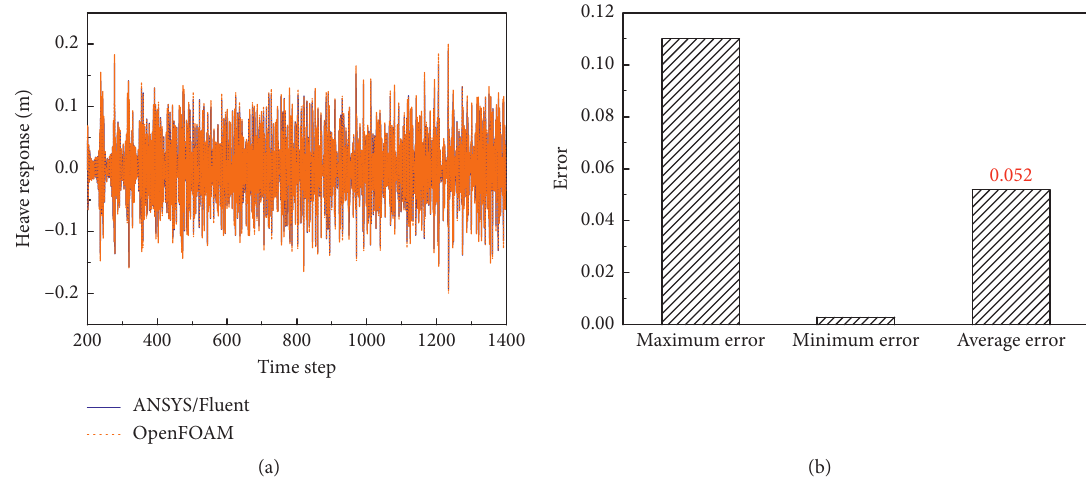
Figure 11: The heave response comparisons of Case 3 by the present and traditional methods: (a) the time series of heave displacement and (b) the average error and time cost ratio statistics compared to